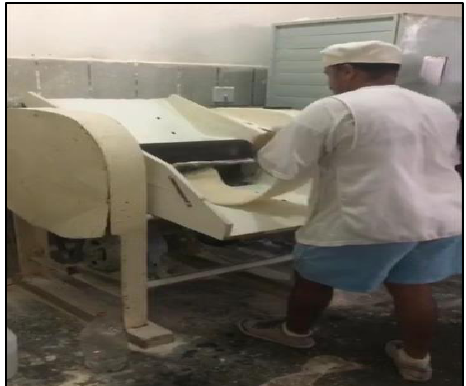
Figura 3: Padeiro realizando a untagem da massa Fonte: Autores, (2018).